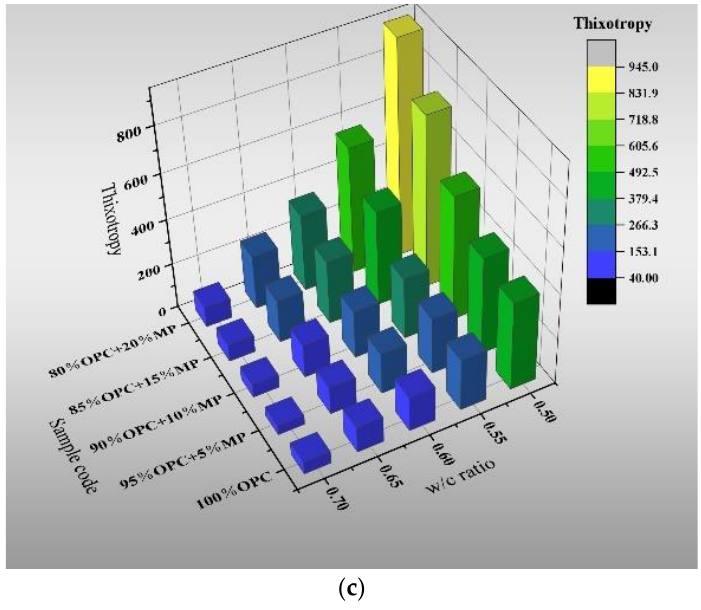
Figure 4. Differentiation of plastic viscosity, yield stress and thixotropy with W/CM at various MP contents. ( a ) Yield stress. ( b ) Plastic viscosity. ( c ) Thixotropy.